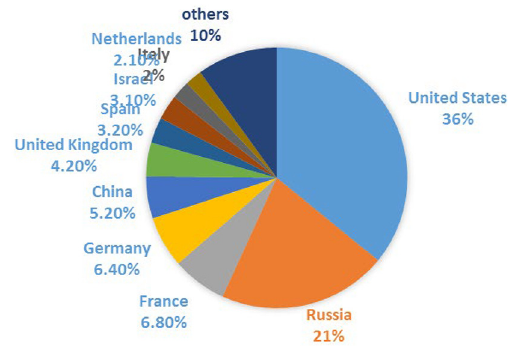
Figure 2. Global share of the